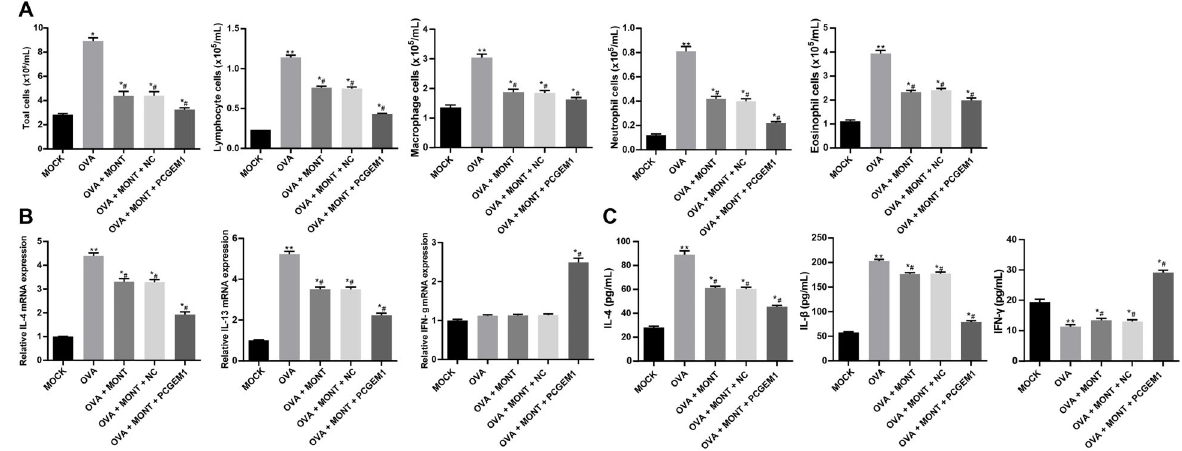
Figure 3. Upregulation of prostate cancer gene expression marker 1 (PCGEM1) strengthened the inhibitory effects of montelukast sodium on in fl ammation in ovalbumin (OVA)-sensitized asthmatic mice. A , The number of total in fl ammatory cells in the bronchoalveolar lavage fl uid of asthmatic mice (n=6) treated with montelukast sodium (MONT) and PCGEM1, and normal control (MOCK). B , mRNA expression of in fl ammatory mediators in lung tissues of animals treated with montelukast sodium and PCGEM1 mimic determined by RT-qPCR (n=3). C , The levels of in fl ammatory mediators in the lung tissues of animals measured by ELISA (n=6). Data are reported as means ± SD. *P o 0.05, **P o 0.01 vs the MOCK group; # P o 0.05 vs the OVA group (one-way ANOVA, followed by Tukey ’ s multiple comparisons post hoc test). NC: negative